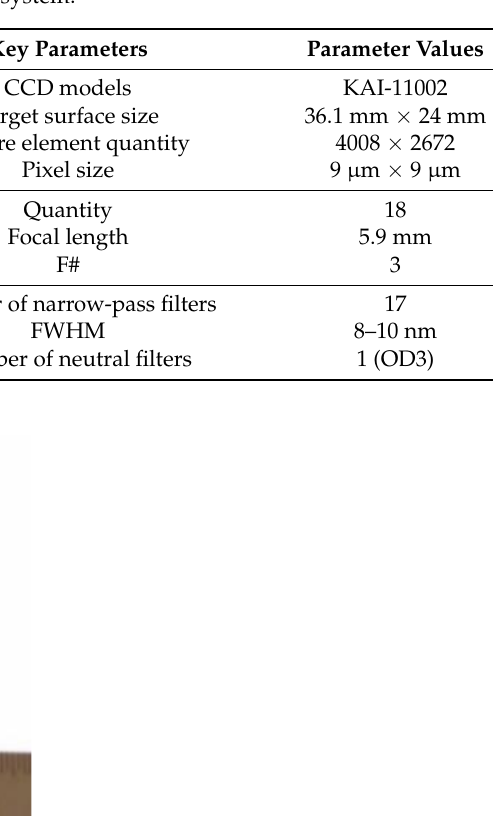
Table 4. Specifications of the low-cost MSI system.